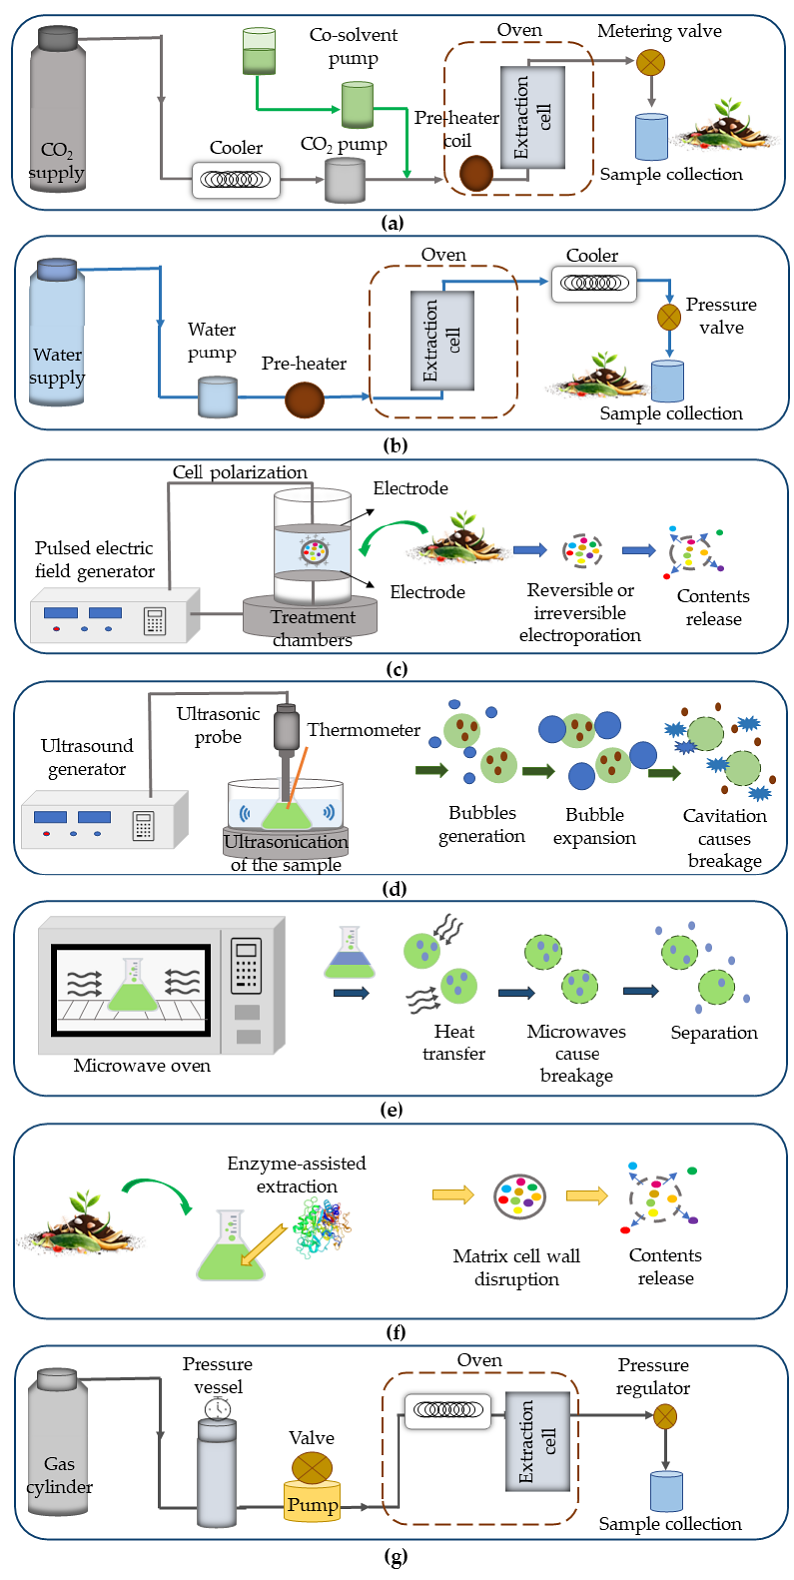
Figure 2. Simplified representation of the most used green extraction procedures, ( a ) supercritical fluid extraction, ( b ) subcritical water extraction, ( c ) pulsed electric fields, ( d ) ultrasound-assisted extraction, ( e ) microwave-assisted extraction, ( f ) enzyme-assisted extraction, and ( g ) pressurized liquid extraction.